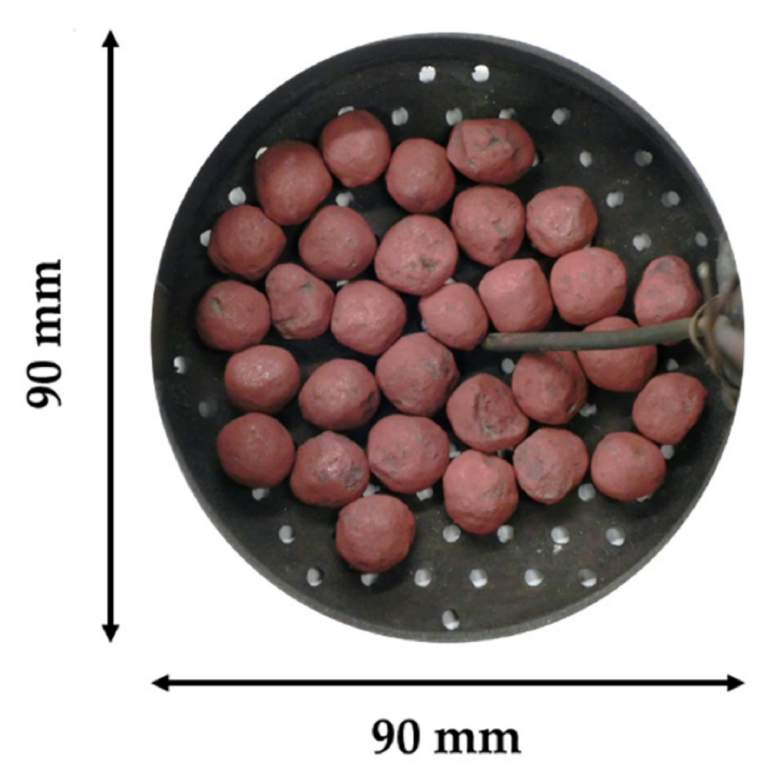
Figure 4. A pellet sample in the BFS basket before